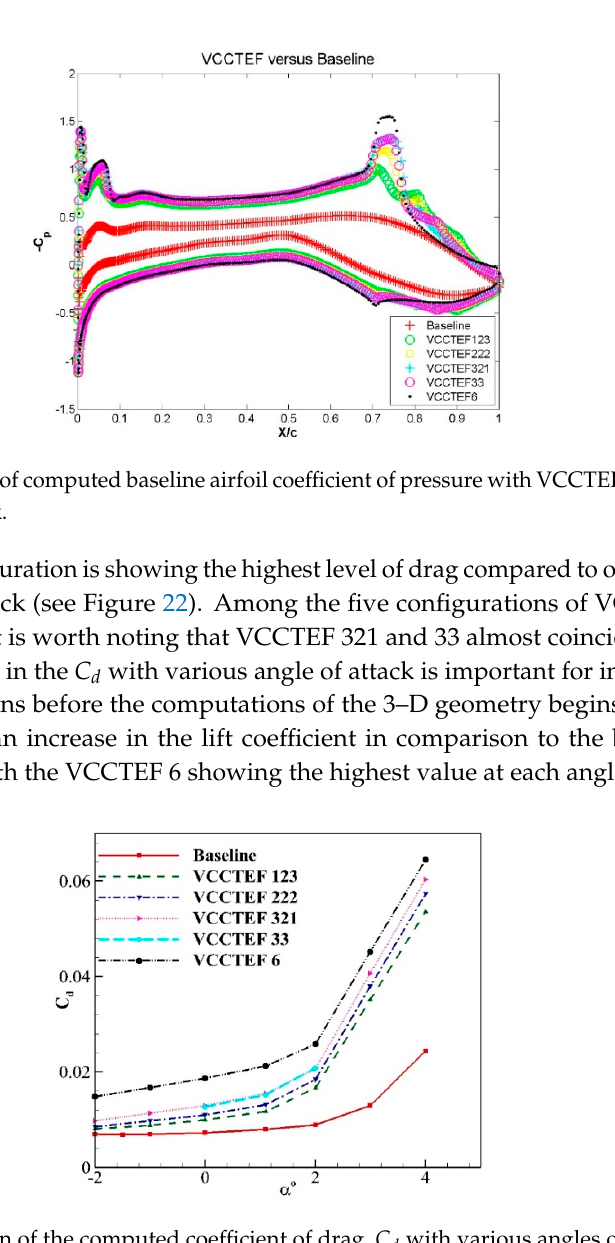
Figure 22. Variation of the computed coefficient of drag, C d with various angles of attack, α .